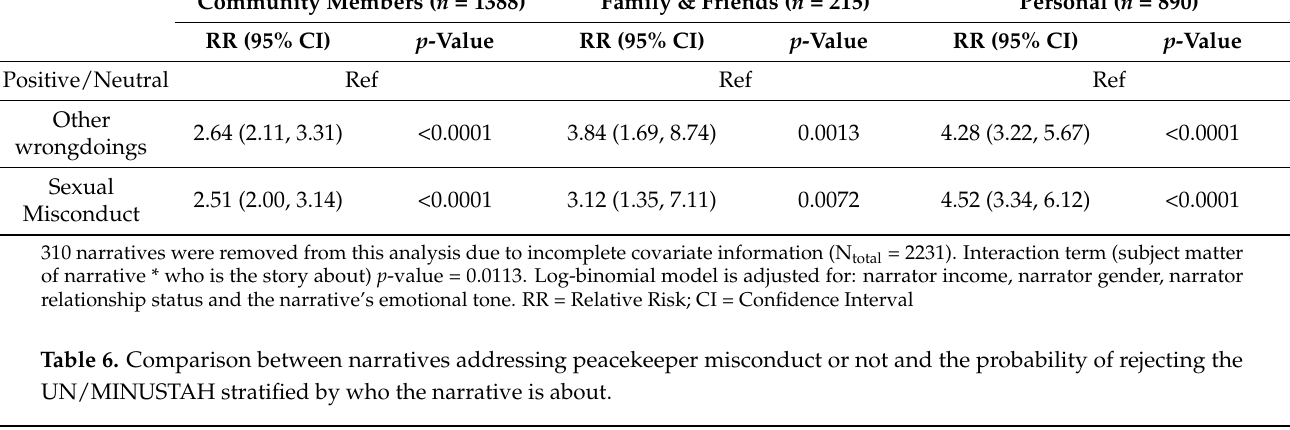
Table 5. Association between narrative subject matter and the probability of rejecting the UN/MINUSTAH stratified by who the narrative is about. Who Is This Story about?